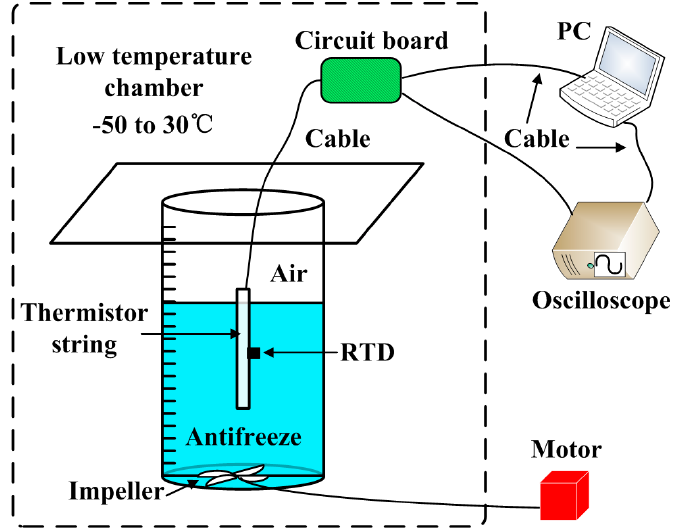
Figure 9. The schematic diagram of the experimental setup of temperature correction.